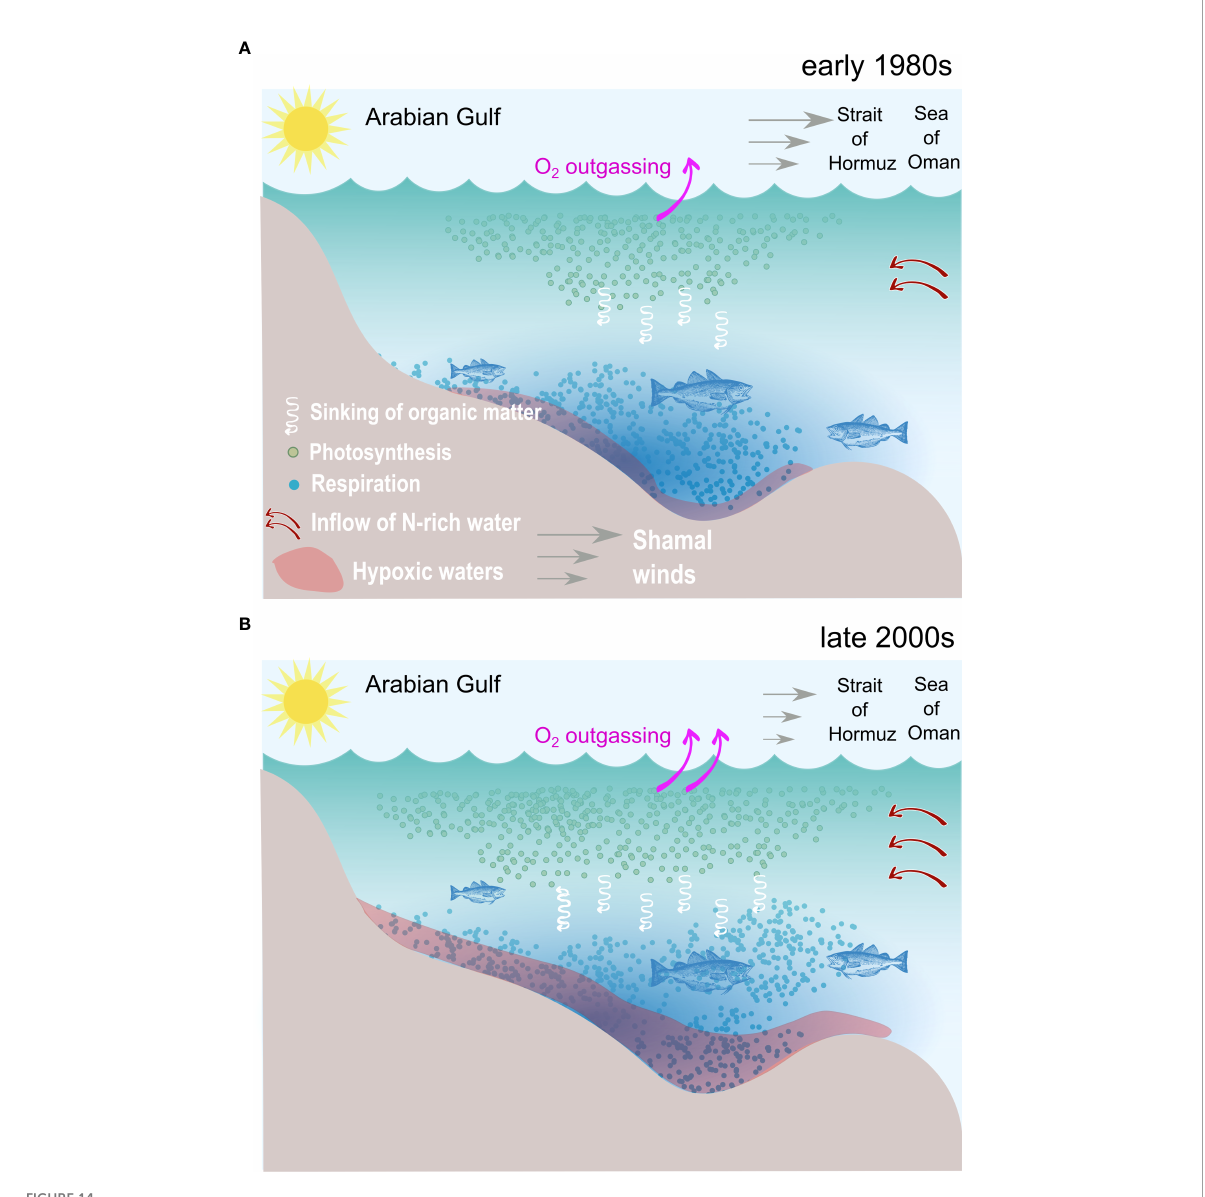
FIGURE 14 A schematic summarizing the main processes responsible for O 2 depletion and near-bottom hypoxia expansion in the Gulf. (A) Conditions in the 1980s: relatively cool conditions favor strong O 2 solubility in the seawater and weaker outgassing. Strong Shamal winds limit nutrient supply from the Arabian Sea in the winter season, thus limiting productivity and respiration at depth, resulting in restricted seasonal hypoxia near the bottom. (B) Conditions in the 2000s: warm conditions lower O 2 solubility in the water and enhance outgassing. Weaker shamal winds favor enhanced nutrient supply from the Arabian Sea during winter. This, together with warming-induced increase in phtoplankton growth rates, enhances productivity and respiration at depth, resulting in an extended near-bottom hypoxia and compressed habitat for sensitive benthic and pelagic